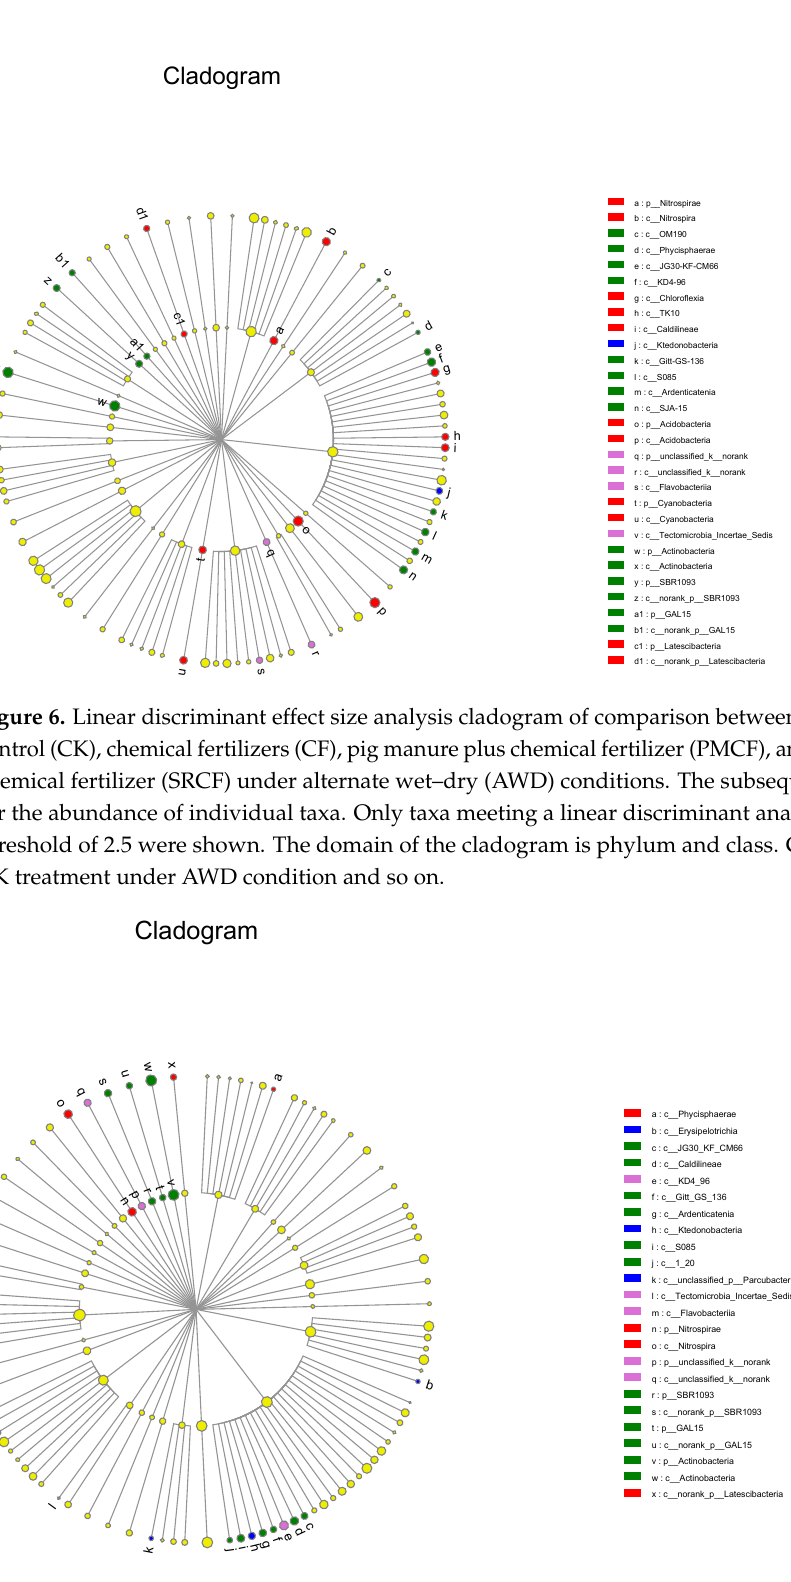
Figure 7. Linear discriminant effect size analysis cladogram of comparison between the unamended control (CK), chemical fertilizers (CF), pig manure plus chemical fertilizer (PMCF), and rice straw plus chemical fertilizer (SRCF) under permanent flooding (PF) conditions. The subsequent colors stand for the abundance of individual taxa. Only taxa meeting a linear discriminant analysis significance threshold of 2.5 were shown. The domain of the cladogram is phylum and class. CKPF showed CK treatment under PF condition and so